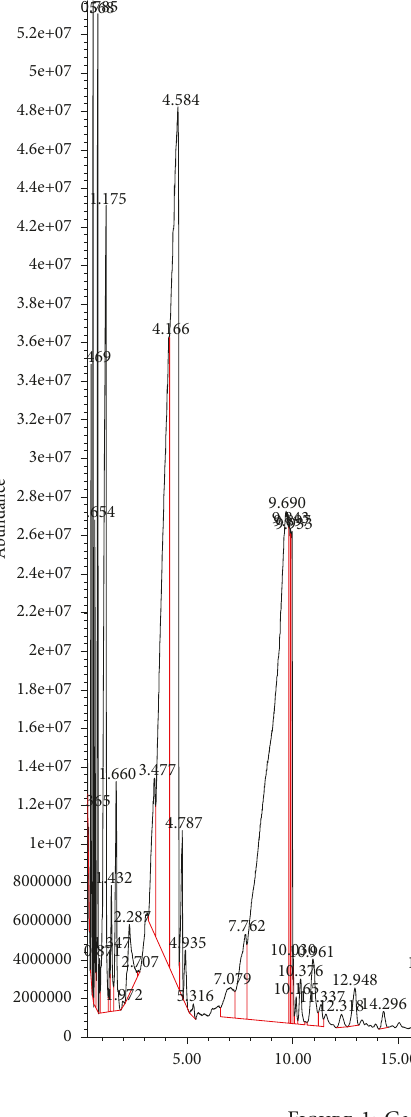
Figure 1: Gas chromatography of S . officinalis essential